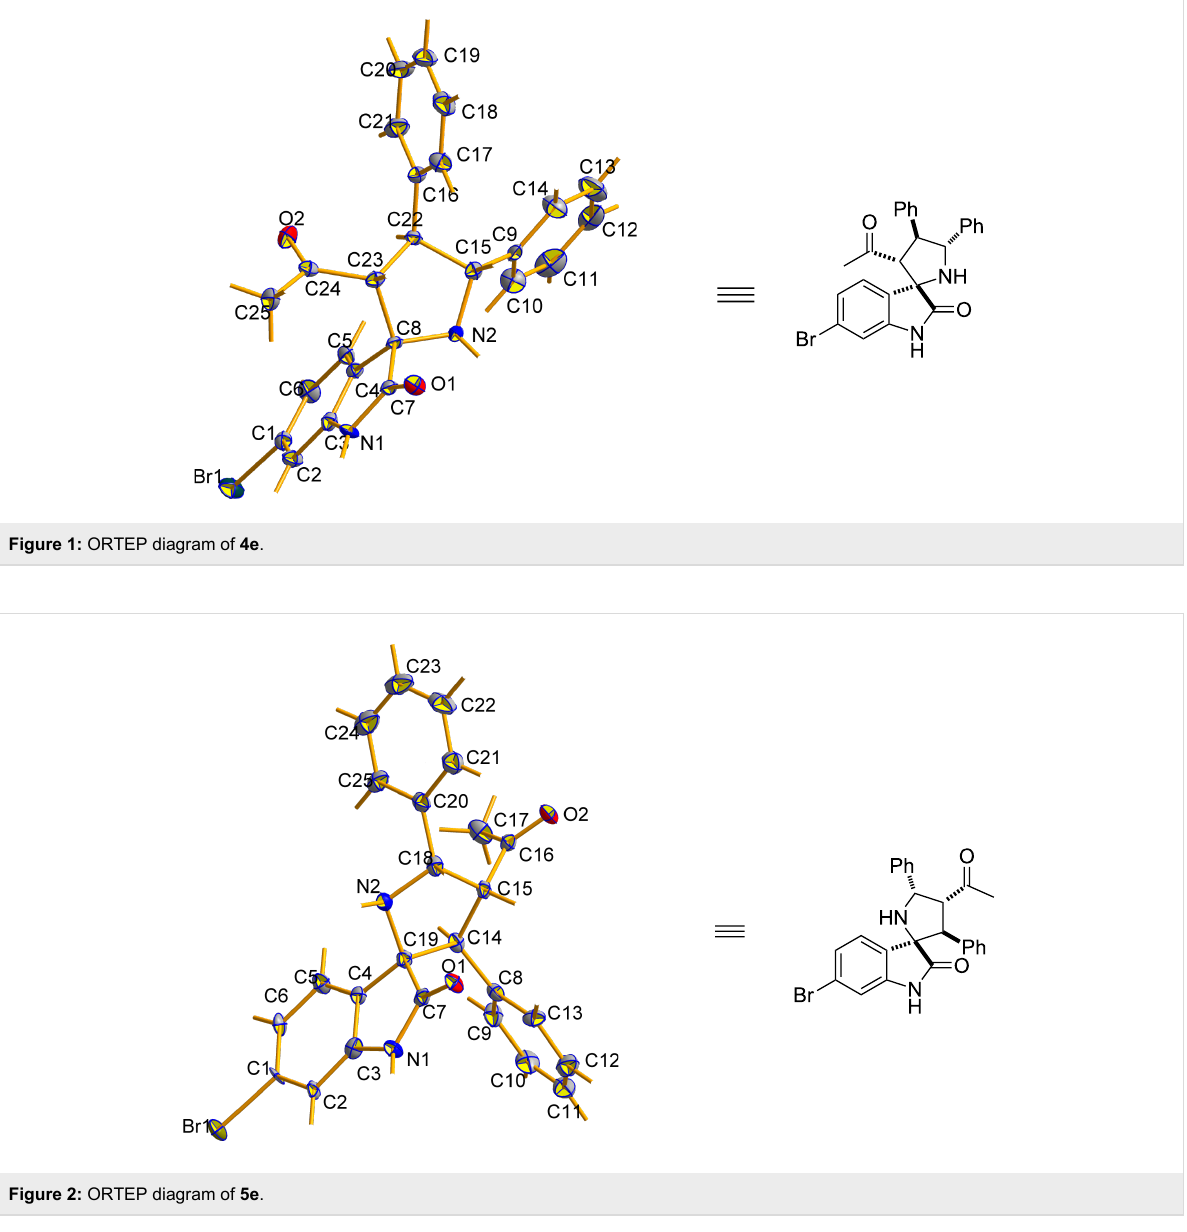
acid, which provides a facile approach to access a wide range of spirooxindole ring systems with novel substitution